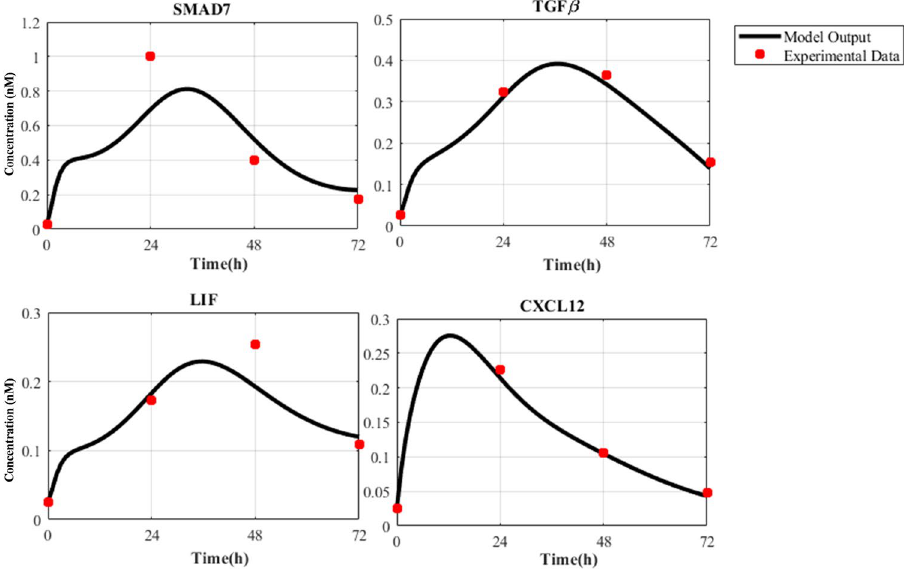
Figure 6. Experimental data and model outputs of ODE modeling of cancer cell. Gene expression profiles of SMAD7, TGFβ, LIF, and CXCL12 molecules in MCF-7 cell over four time points (0, 24, 48, and 72 h) and their corresponding behavior in the dynamic model are depicted by red dots and black curves,